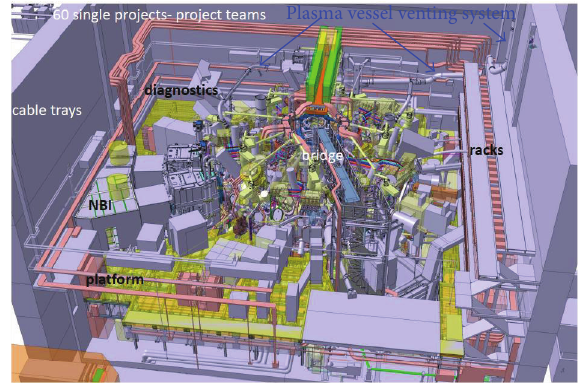
Figure 1: CAD view of venting system connected to PV [6].